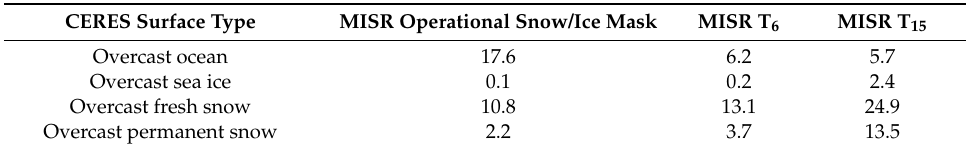
Table 6. Surface classification inconsistency (%) between CERES and MISR over nadir CERES